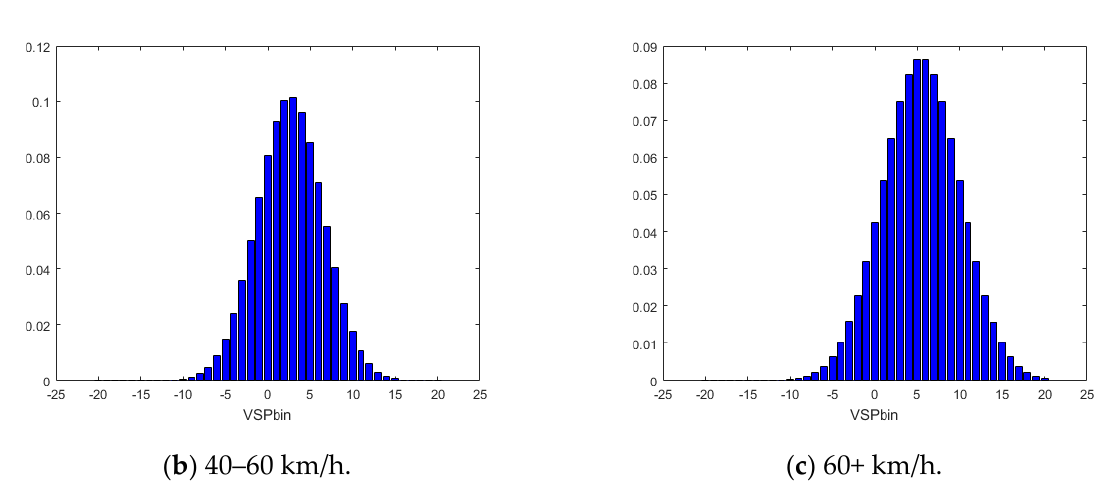
Figure 3. The Vehicle Specific Power distribution at different speed intervals.